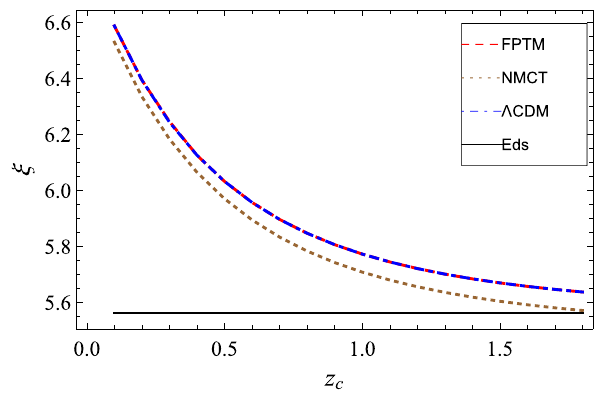
Fig. 13 The behaviour of the linear tachyonic perturbations δ l versus a for the Λ CDM and FPTM models